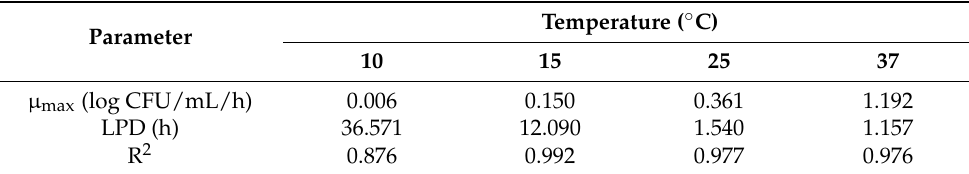
Table 1. Kinetic parameters as calculated by the Baranyi model for the growth of Salmonella spp. in LEW during storage at 10, 15, 25, and 37 ◦ C.